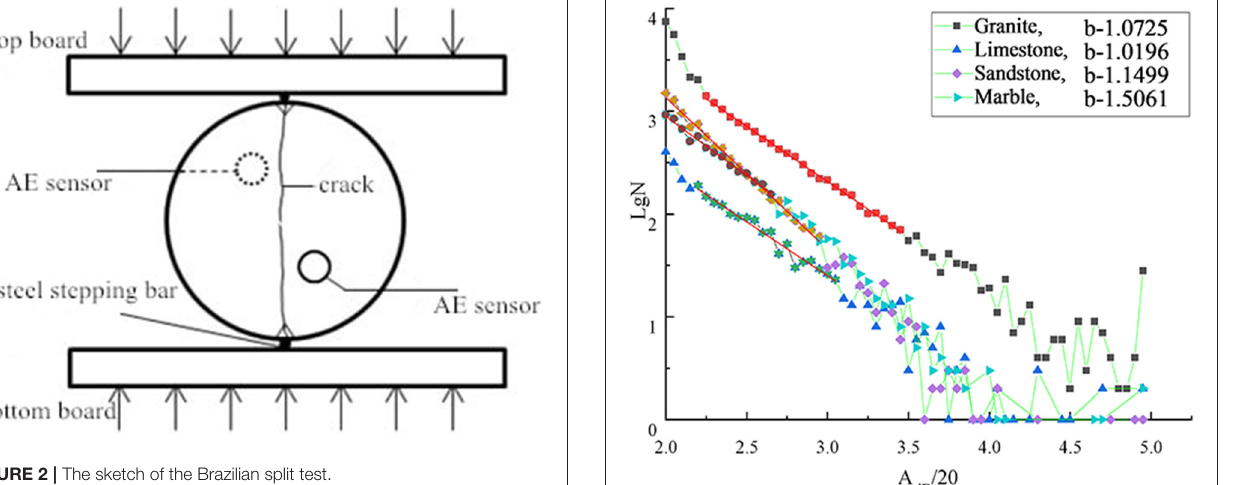
FIGURE 2 | The sketch of the Brazilian split test.